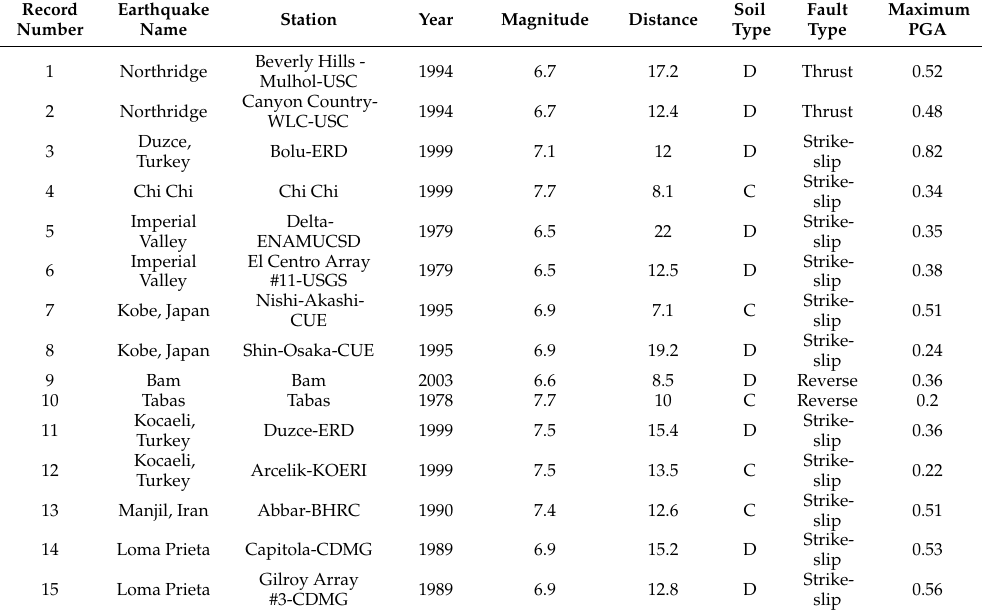
Table 3. Selected used ground